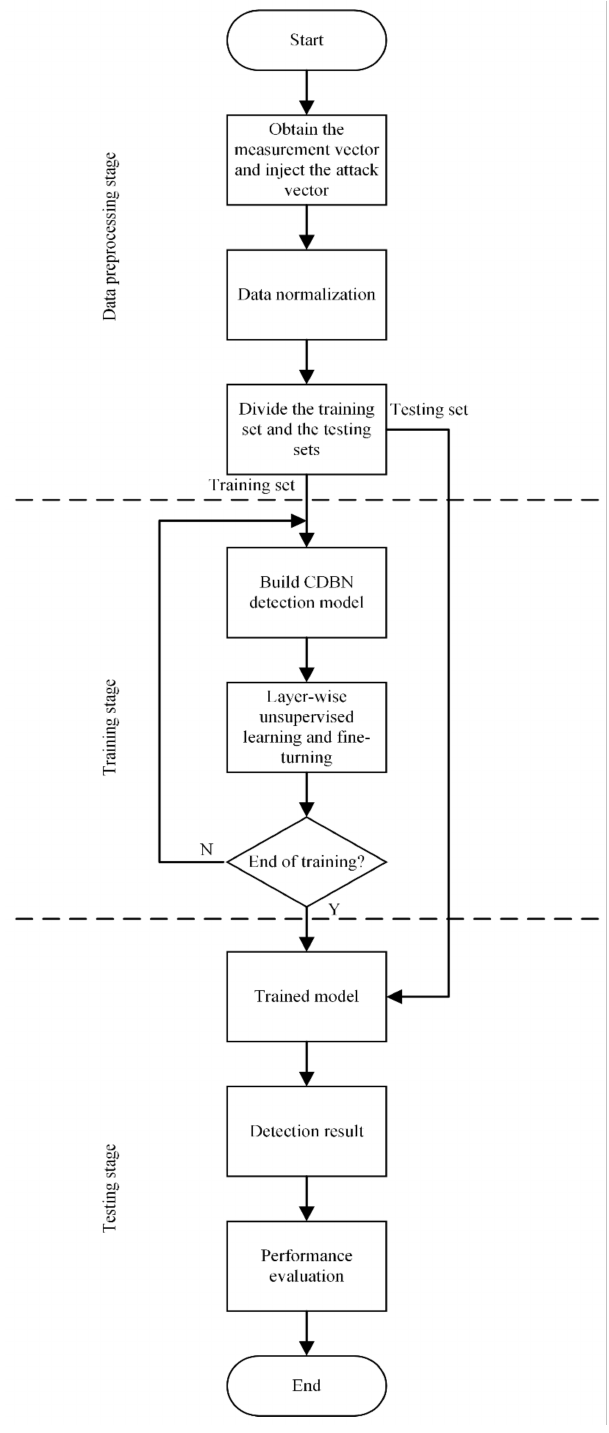
Figure 6. The CDBN-based detection model flow